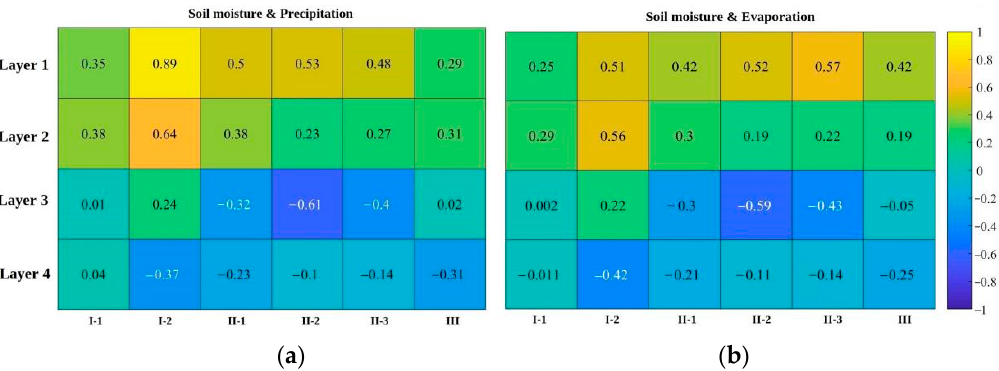
Figure 9. Partial correlation coefficient between the precipitation ( a ), evaporation ( b ), and soil moisture at various depths for different vegetation types.